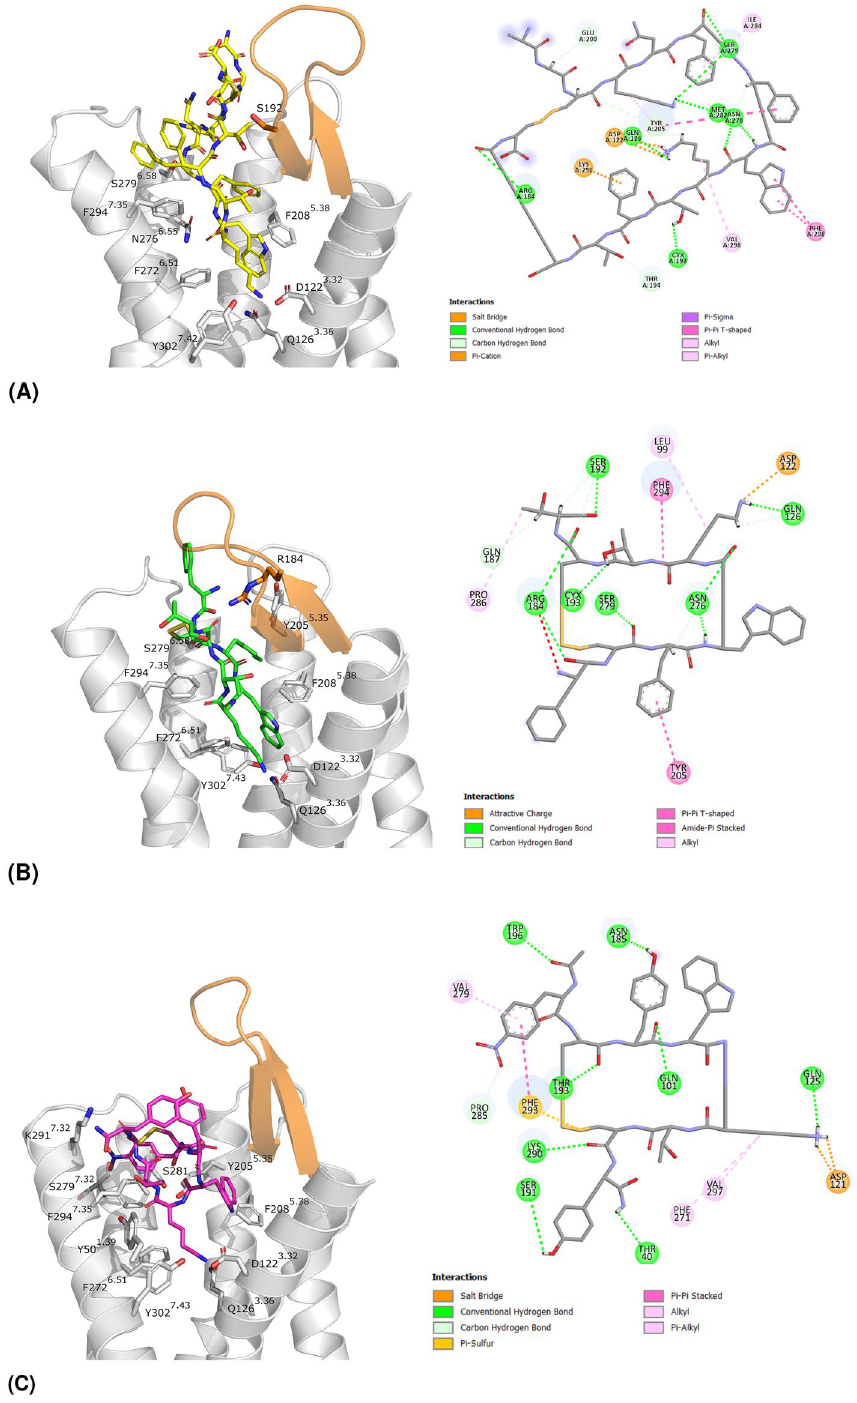
Figure 4. Representatives of the most populated cluster of ( A ) SSTR2-SST14 (64.5%) in yellow, ( B ) SSTR2- OCT (42.9%) in green, ( C ) SSTR2-CYN (79.1%) in magenta. On the left: 3D representation, ECL2 is coloured in orange, the interacting residues are represented in sticks. On the right: 2D interaction diagram, generated by Discovery Studio 42